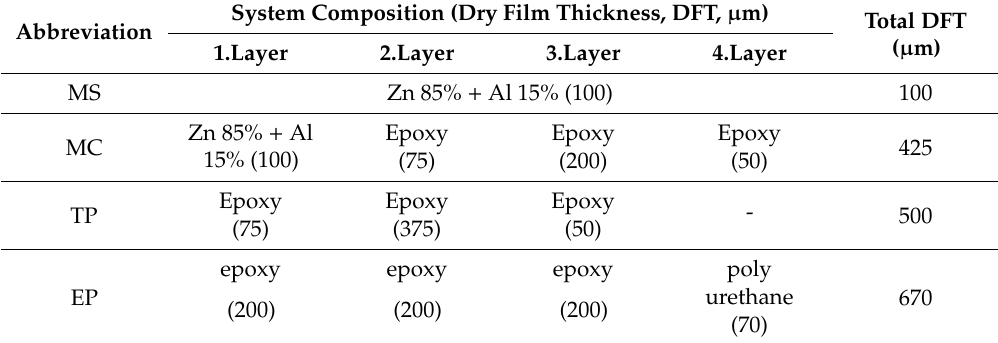
Table 1. Coating